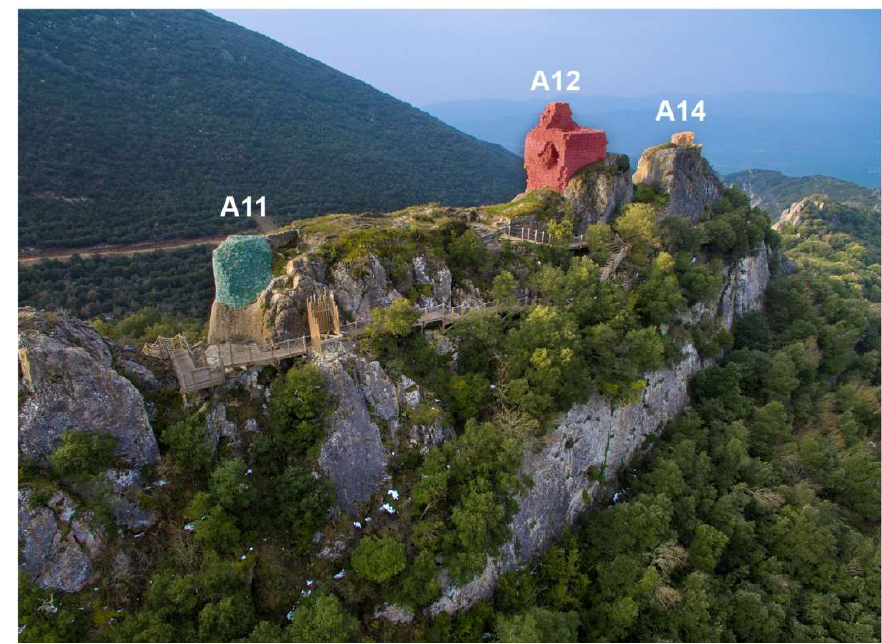
Figure 2. Studied structures at Portilla Castle. West Tower (A14), Tower Keep (A12), and East Tower (A11).